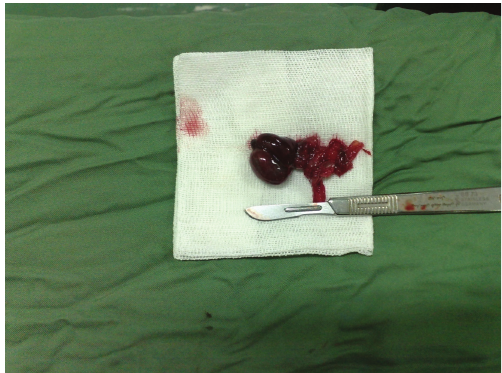
Figure 3: Removed necrosed